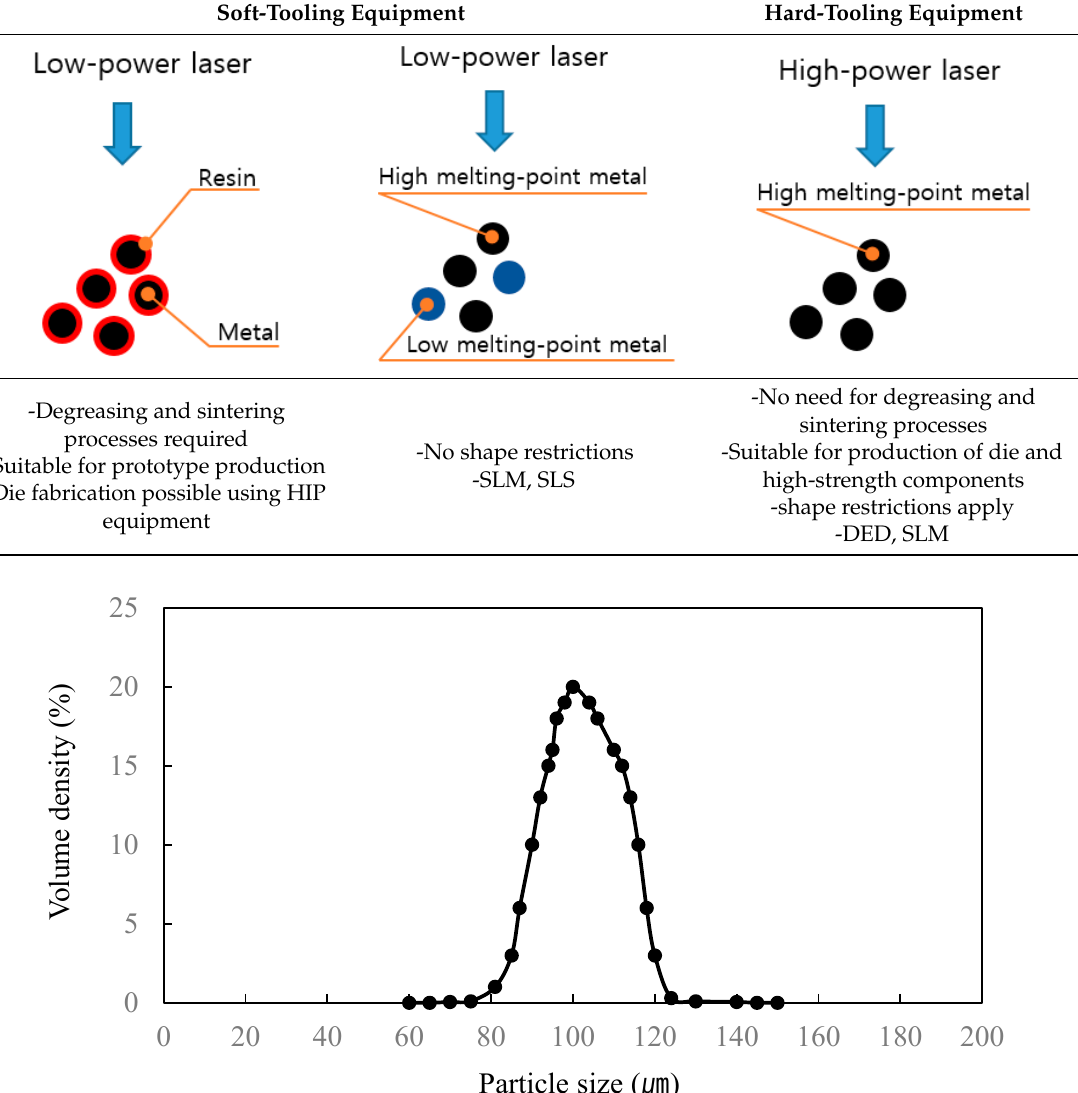
Figure 2. HTCS-150 powder particle size for the laser deposition.